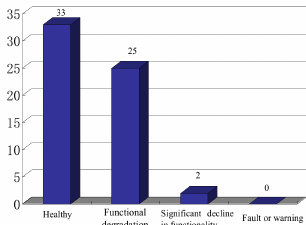
Figure 8. The distribution of the di ff erent health status of 60 sorties.